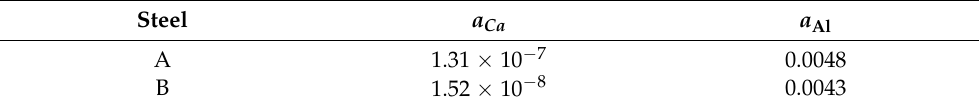
Table 4. Activity of Ca and Al in steel A and steel B.